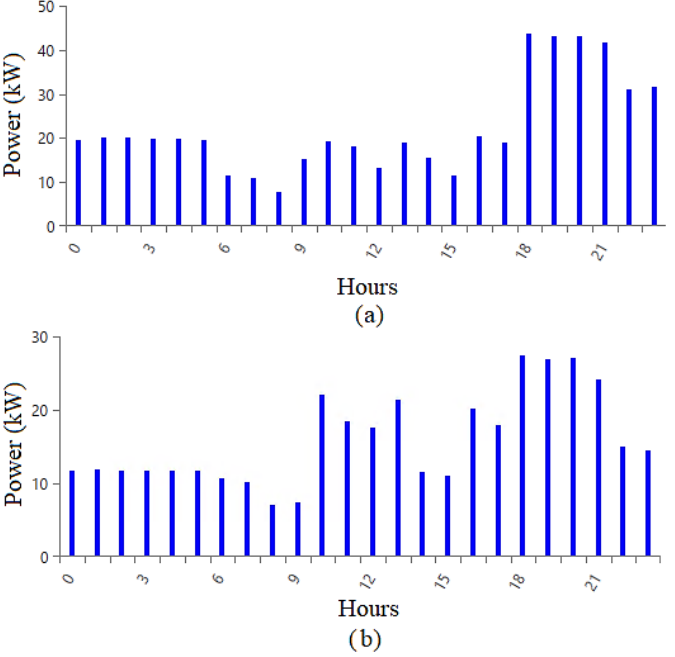
Figure 3. Daily load profiles ( a ) without EE initiative and ( b ) with EE